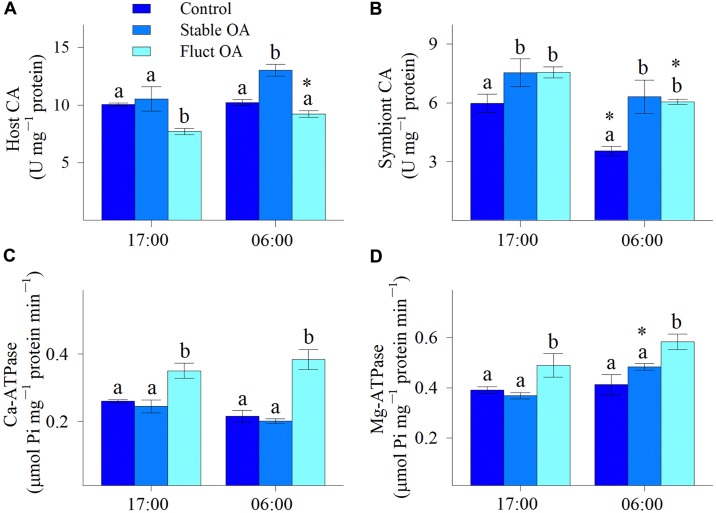
Enzymatic activities of P. damicornis recruits exposed to ambient pCO2 (Control), steady-high pCO2 (Stable OA), and fluctuating-high pCO2 (Fluct OA). (A) Host CA; (B) symbiont CA; (C) Ca-ATPase; and (D) Mg-ATPase. Data shown as mean ± SE. Different letters indicate statistically significant differences in mean values among treatments, while asterisks denote significantly different means between night and day within each treatment.